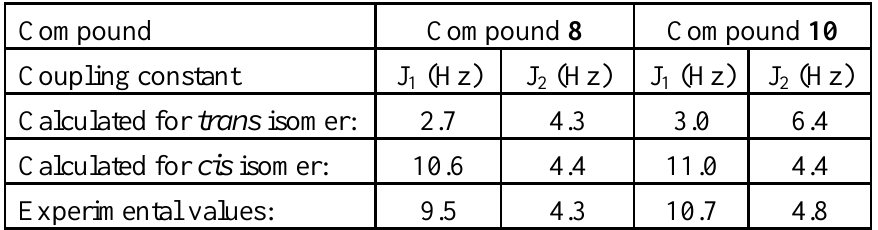
Table 1. Calculated and experimental vicinal coupling constants for compounds 8 and 10